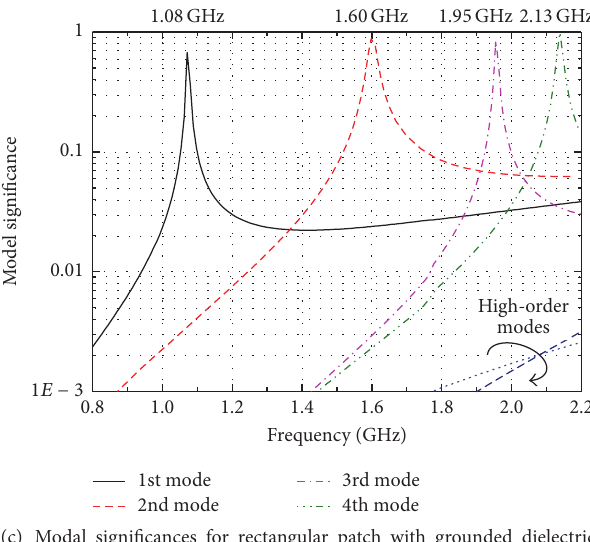
(c) Modal significances for rectangular patch with grounded dielectric substrate ( 𝜀 𝑟 = 3.38 ) Figure 1: Modal significances for the same rectangular patch but with different dielectric substrate and ground plane